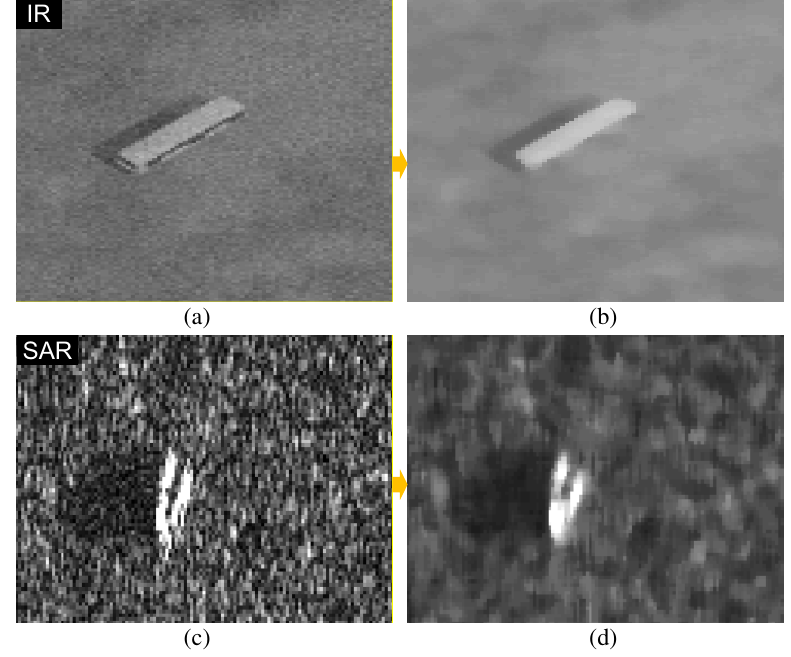
Figure 9. Proposed MLAF-based thermal and scattering noise reduction results: ( a ) noisy IR image; ( b ) MLAF-based noise reduction; ( c ) noisy SAR image; ( d ) MLAF-based noise